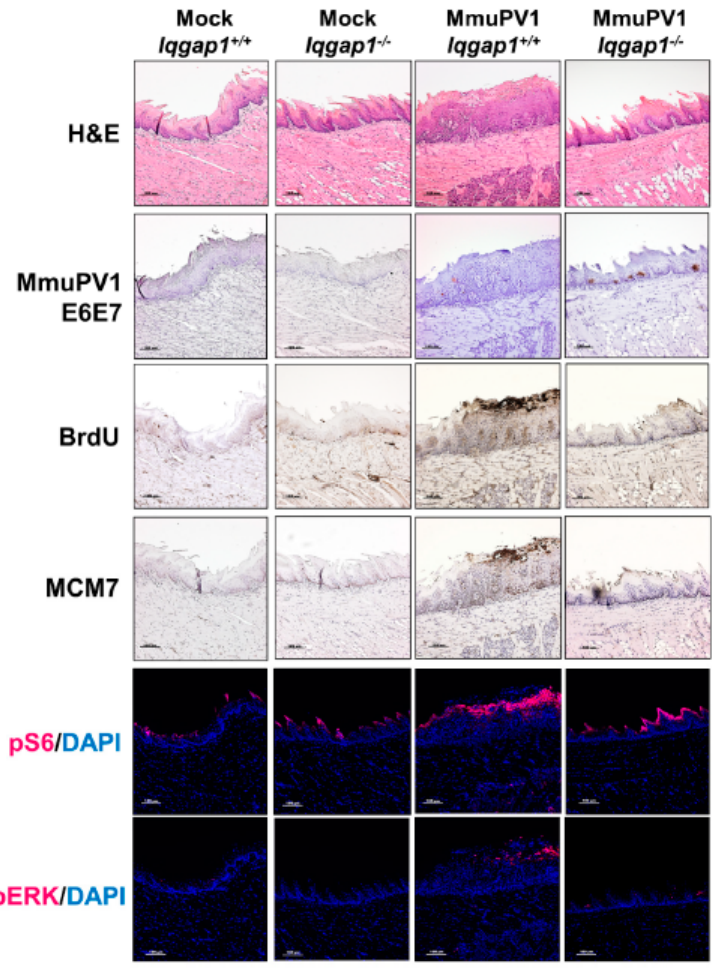
Figure 4. Biomarker analysis of MmuPV1-associated cytoplastic mild dysplastic lesions arising in Iqgap1 +/+ and Iqgap1 − / − mice. The presence of MmuPV1 was detected by in situ hybridization against the MmuPV1 E6/E7 transcripts. MCM7 and BrdU were detected by immunohistochemistry. pERK and pS6 were detected by TSA-enhanced immunofluorescence (red: pERK or pS6; blue: DAPI). 2.7. MmuPV1 Infection of Tongue